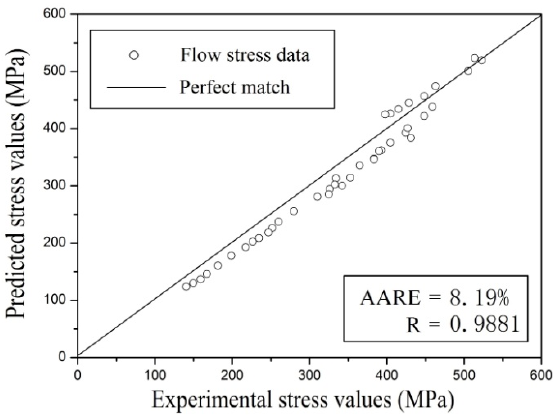
Figure 12. The correlation between predicted and experimental results at temperature of 1023 K.